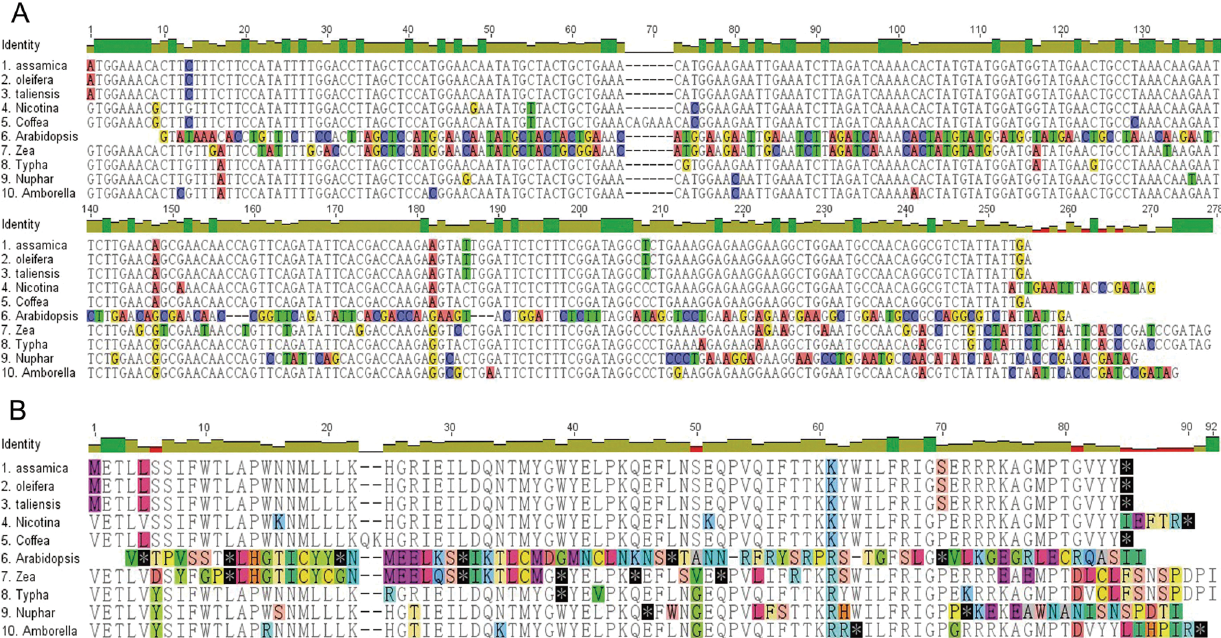
Figure 3. Alignment of the ycf15 gene and protein sequences in the ten representative species of angiosperms. A) alignment of the ycf15 gene sequences; B) alignment of the ycf15 protein sequences. Black asterisks indicate stop codon in protein sequence.